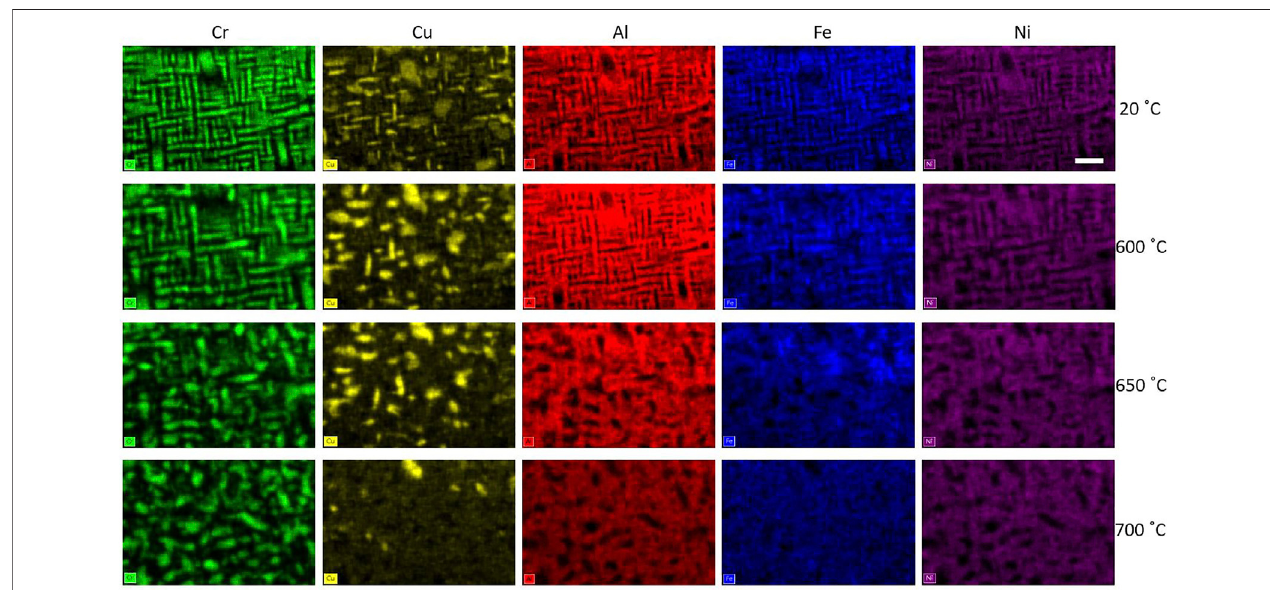
FIGURE 1 | EDS elemental maps acquired during in-situ STEM heating experiments of Al 1.3 CoCrCuFeNi: (top to bottom) 20, 600, 650, and 700 ° C. Images show the compositional distributions for (left to right) Cr, Cu, Al, Fe, and Ni. Scale bar is 5,000 Å.